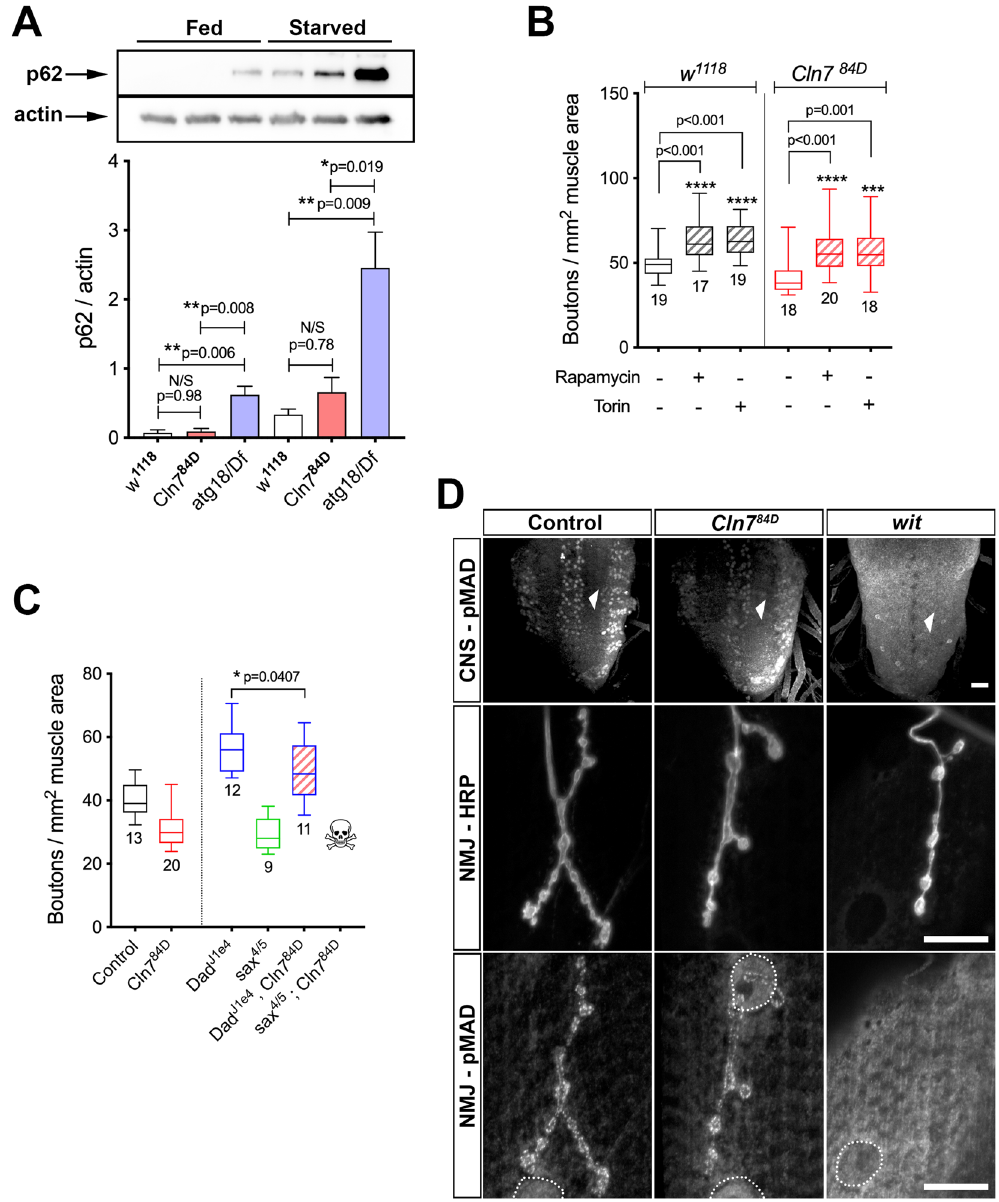
Figure 5. Autophagy and retrograde BMP signaling are unaffected by loss of Cln7. ( A ) The lysosomal substrate, p62, does not accumulate in control of Cln7 84D larvae when feeding but does in atg18 mutants. ( A ) After 4 h starvation, p62 accumulates in control animals. Accumulation is slightly but not significantly increased in Cln7 84D larvae. In contrast, p62 accumulates to very high levels in starved atg18 mutants. Bars show mean p62 band intensity + / − SEM normalized to actin, n = 3 for each. * p = 0.05; ** p < 0.01, ANOVA. ( B ) Inhibition of TORC1 with rapamycin or TORC1 and 2 by torin drives NMJ overgrowth by increasing autophagic flux. Cln7 mutant larvae respond similarly to control w 1118 larvae suggesting no block in autophagy. *** p = 0.01; **** p < 0.001; ANOVA with Dunnett’s post-hoc comparisons, n is indicated. ( C ) Mutations affecting retrograde signaling from the muscle alter neural development. Mutations in the inhibitory SMAD, Dad , drive overgrowth of the NMJ; mutations in the saxophone type I TGF β receptor result in underdevelopment at a similar level to Cln7 mutants. A double Dad;Cln7 mutant displays a small but significant moderation of the Dad phenotype (2-tailed t-test: t = 2.181, Df = 21, p = 0.0407). A sax;Cln7 double mutant is lethal early in development. Control w 1118 and Cln7 84D data from Figure 6 are included for comparison. ( D ) Mad is phosphorylated after binding of the Gbb ligand to Tkv, Sax and Wit receptors in the neuron. Characteristic pMad staining is clearly visible in columns of motor neurons in the control and Cln7 84D CNS but is absent in a wit mutant CNS (anti-pMad, top row, arrowheads). pMad staining in boutons is also present in boutons in control and Cln7 84D NMJs but absent in a wit mutant (anti-pMad, bottom column; anti-HRP marks the neuronal plasma membrane, middle column). Similarly, pMad is localized within muscle nuclei but absent in wit mutants (dashed circles). Scale bar = 20 μ